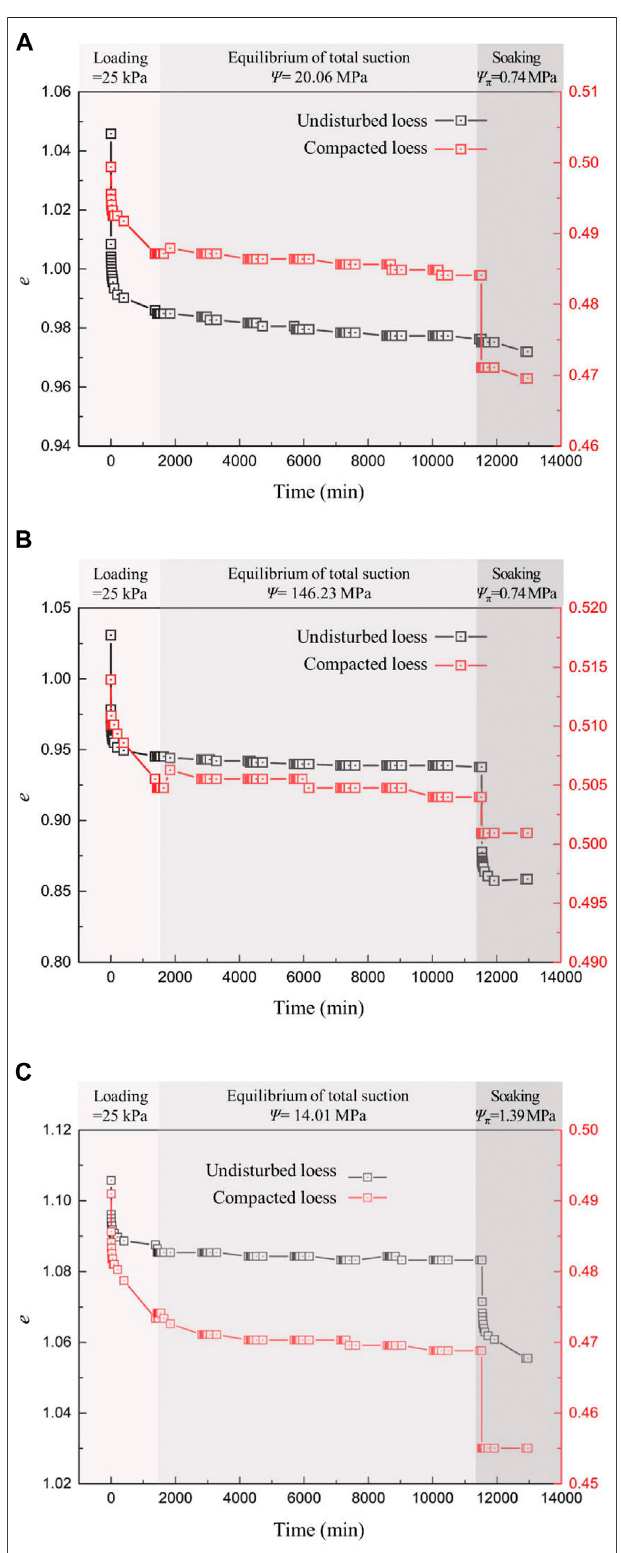
FIGURE 6 | The e - Time curves of undisturbed and compacted loess under impact of total suction and osmotic suction: (A) Ψ = 20.06 MPa and